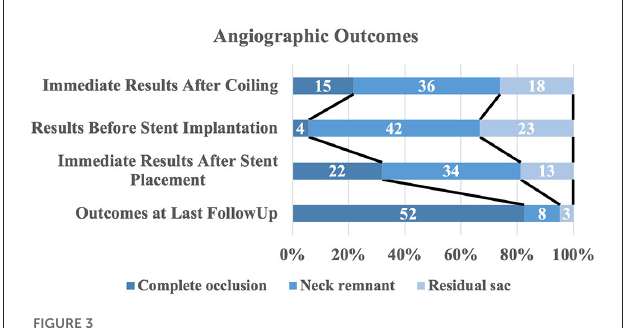
FIGURE3 Distribution of angiographic outcomes by treatment stage. The raw distribution of results is shown.